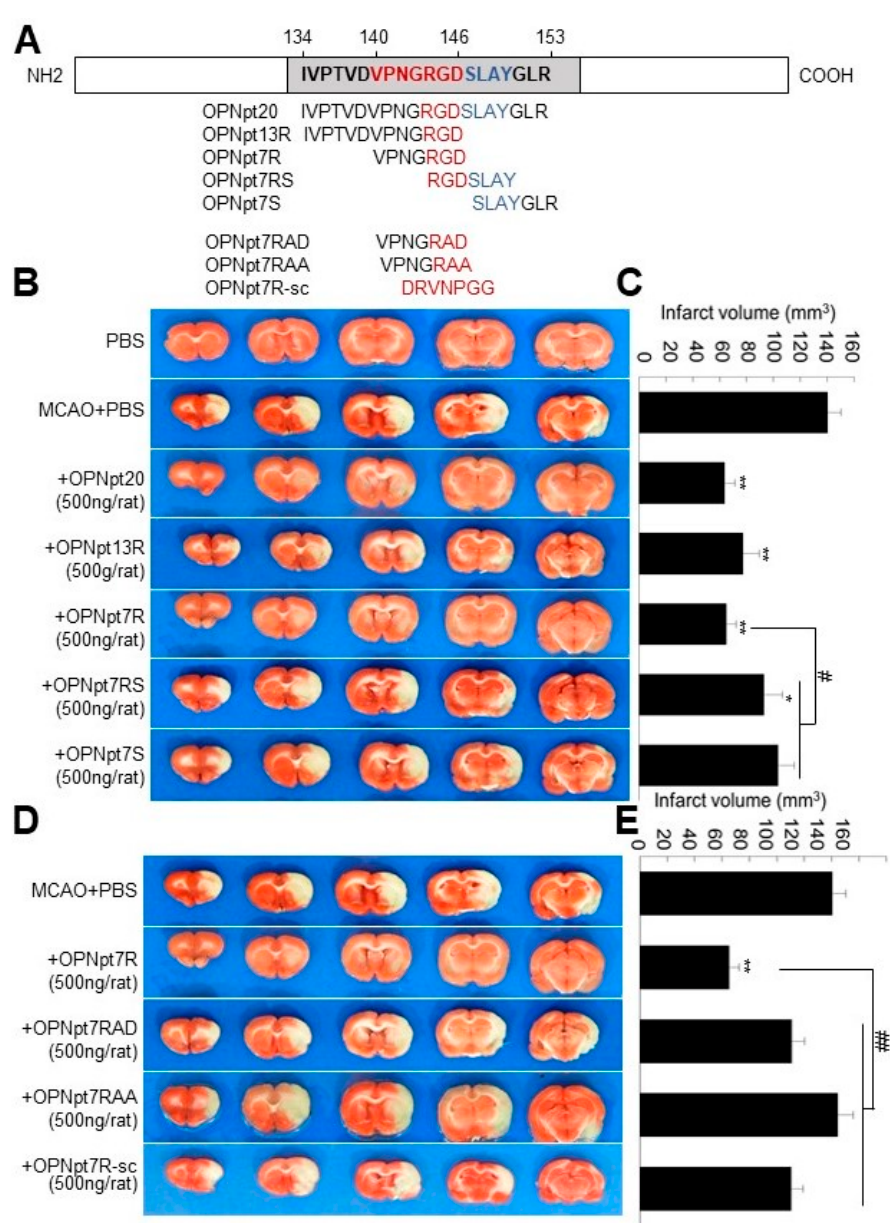
(Figure 1D,E). These results indicate a critical role for the RGD motif in OPNpt7R-medi- ated infarct suppression in the post-ischemic brain.